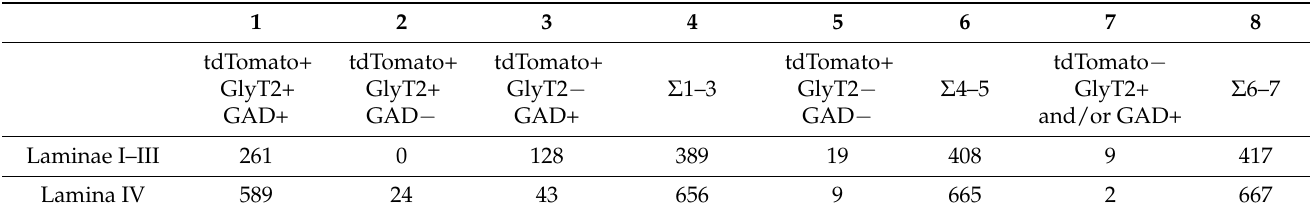
Table 1. Numbers of neurons in which different combinations of tdTomato, GlyT2, and GAD65/67 mRNA were detected in laminae I–III and lamina IV of the spinal dorsal